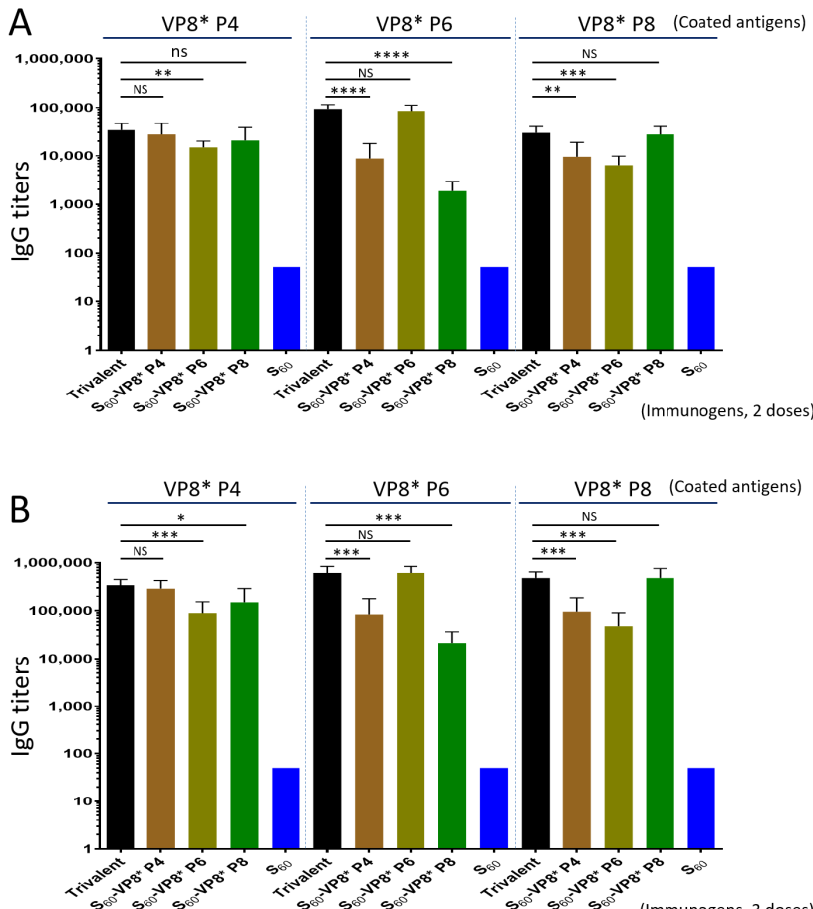
Figure 4. The trivalent S 60 -VP8* PVNP vaccine (trivalent) induced higher and broader IgG responses in mice toward the three homologous VP8* antigens (black columns) compared with those elicited by the three single-valent S 60 -VP8* PVNPs (brawn/cyan/green columns) after two ( A ) and three ( B ) immunizations. The Y -axis shows the VP8*-specific IgG titers, while the X -axis shows different vaccines or immunogens, as indicated. Statistical differences between data groups with corresponding p -values are calculated and shown in the Supplementary Materials. “NS”, non-significant for p -values > 0.05; “*”, significant for p -values < 0.05; “**”, highly significant for p -values < 0.01; “***”, extremely significant for p -values < 0.001; “****”, extremely significant for p -values <